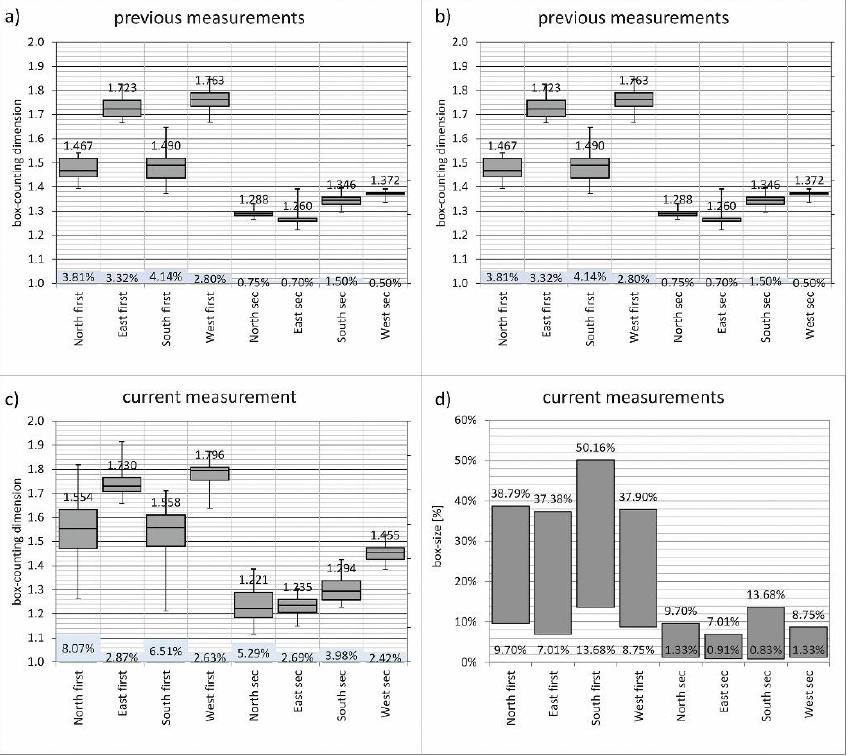
Figure 16. Comparison of previous measurements (Lorenz 2014) of House Mandl top: ( a , b ) with current method, bottom: ( c , d ), with ( a , c ) giving the box plot of 𝐷 𝐵 and ( b , d ) giving the ranges of box sizes in relation to the building height.